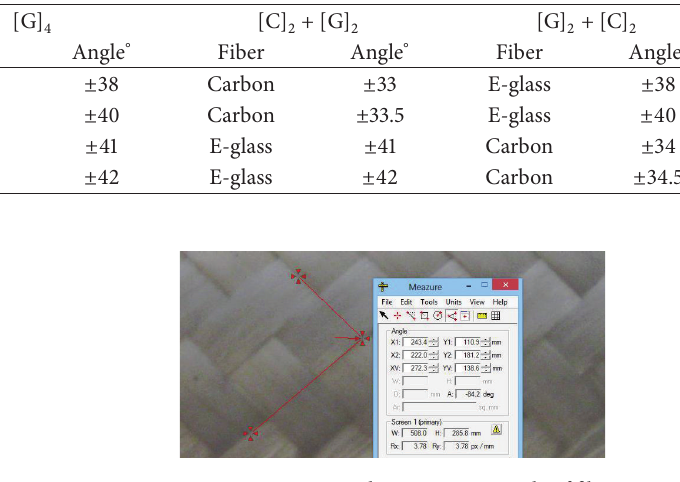
Figure 6: Measuring the orientation angle of